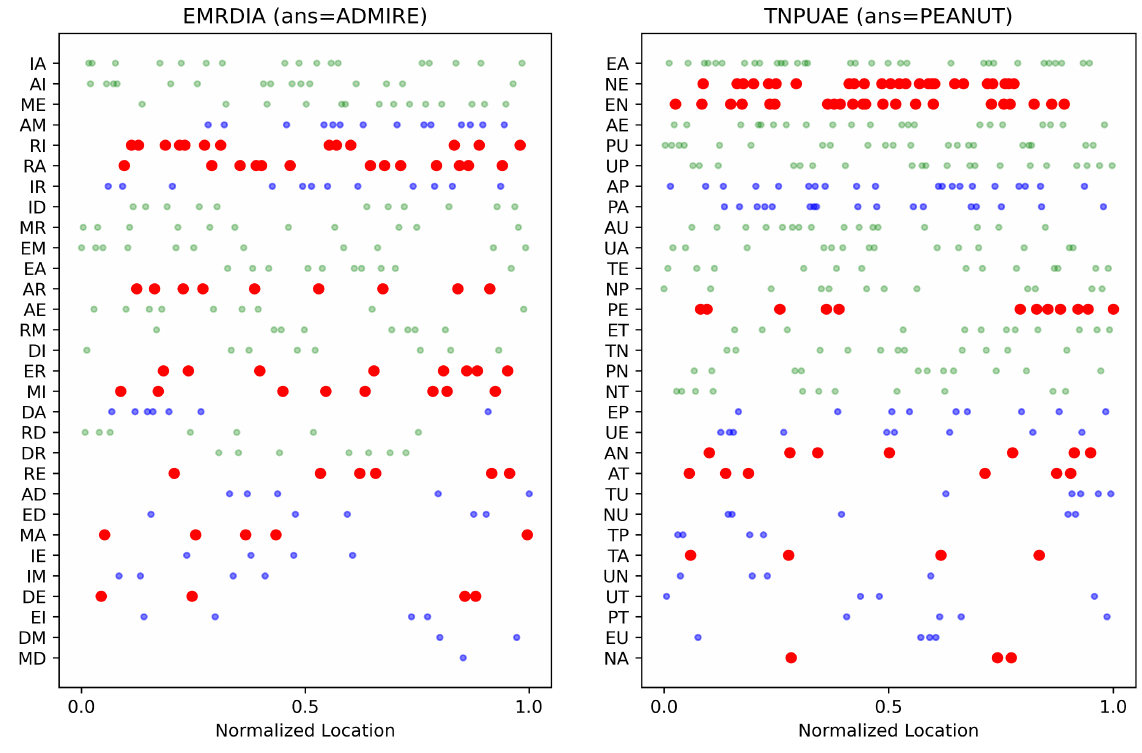
Figure 6. Sample letter sequences. Top: For a given letter sequence, we can locate the occurrences of a particular bigram (in this example, JU and OR) and determine its frequencies and average location. Bottom: The occurrences of different bigrams are shown as dots in each scatter plot. The horizontal axis represents the normalized length of the full letter sequence. The bigrams whose letters are adjacently located are shown in green. Non-adjacent, common bigrams in the English language are shown in red. The rest of the bigrams are shown in blue. There are 30 unique bigram combinations with six letters, and 12 bigrams are from adjacent letters. The example on the left is for an anagram EMRDIA, where these six letters were displayed clockwise. EM, MR, RD, DI, IA, AE, and their reverses (ME, RM, etc.) are adjacently located in this